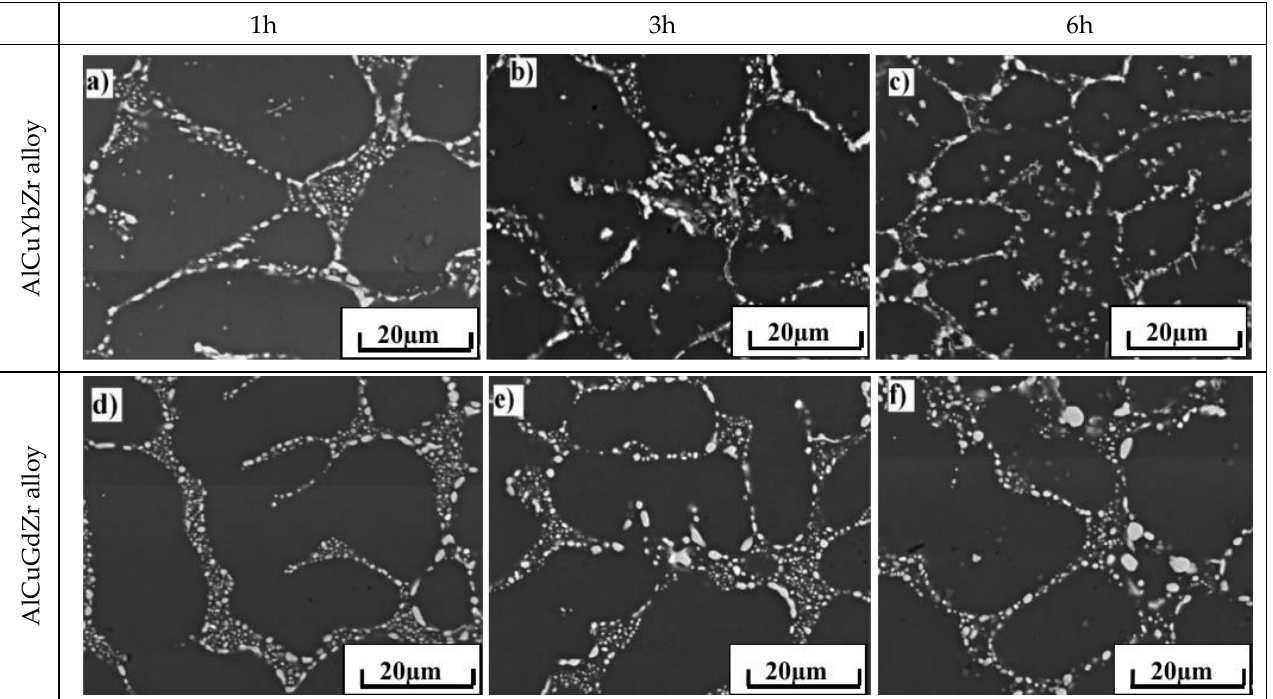
Figure 5. Microstructure evaluation of the AlCuYbZr ( a – c ) and AlCuGdZr ( d – f ) alloys after homogenization treatment for 1 ( a , d ), 3 ( b , e ), and 6 ( c , f ) h.